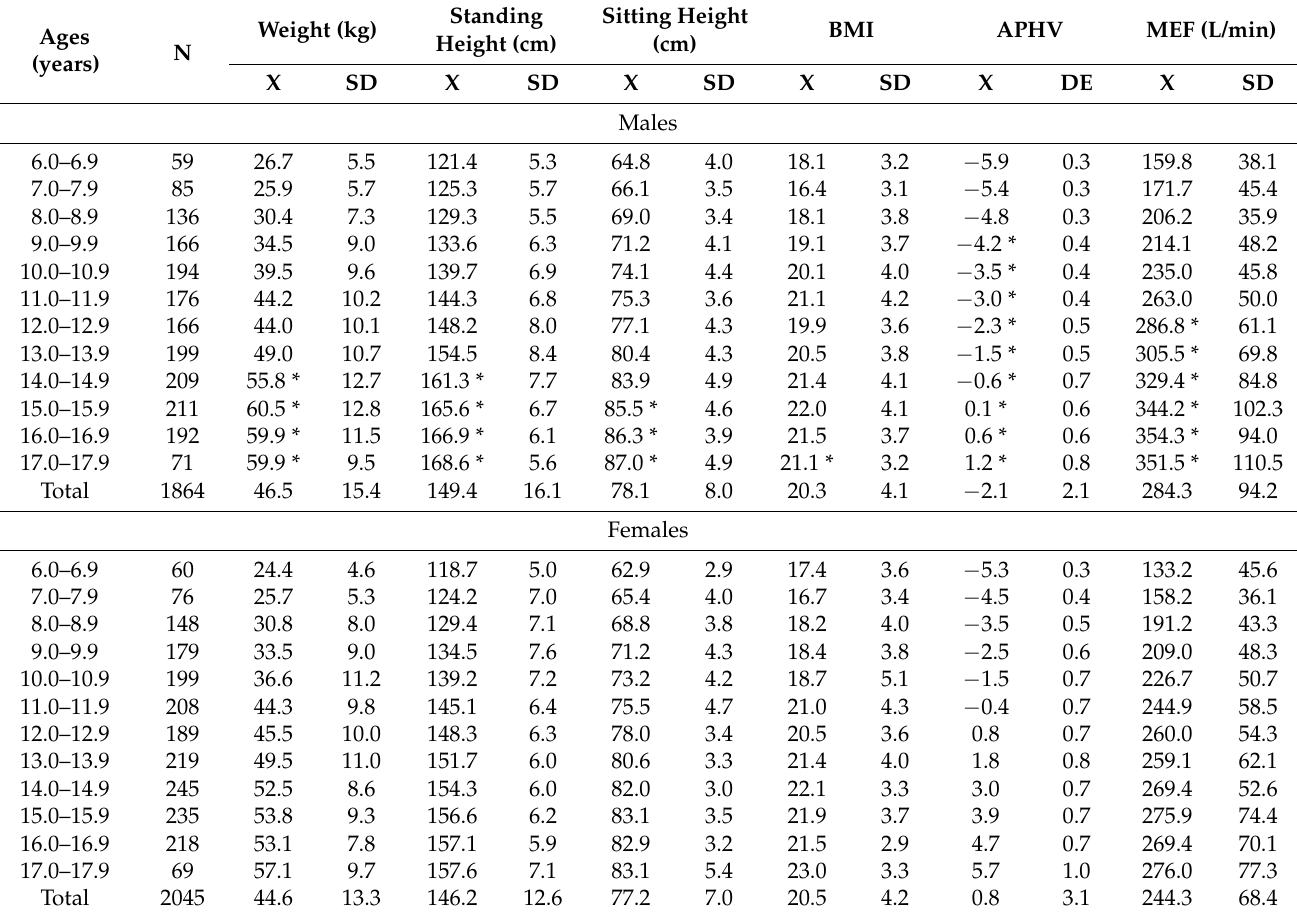
Table 1. Variables representing the sample